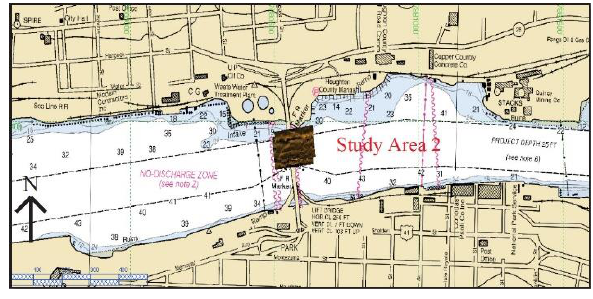
Figure 5. The Map of the Second Study Areas (Base Map From: